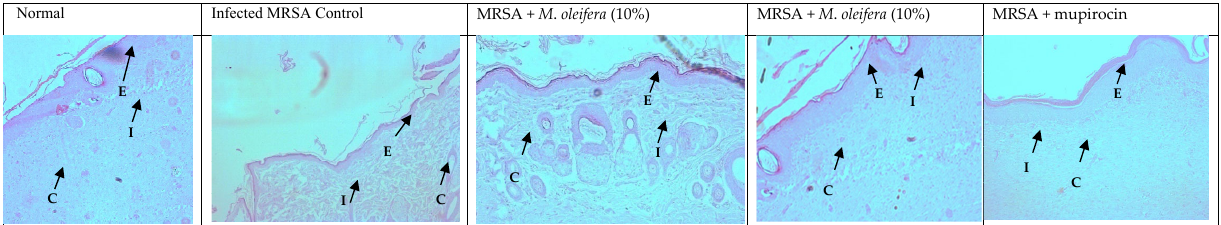
Figure 7. Skin histology of MRSA ‐ infected wound (stained with H & E) after different treatments showing epidermis (E), capillaries (C), and inflammatory cells (I).